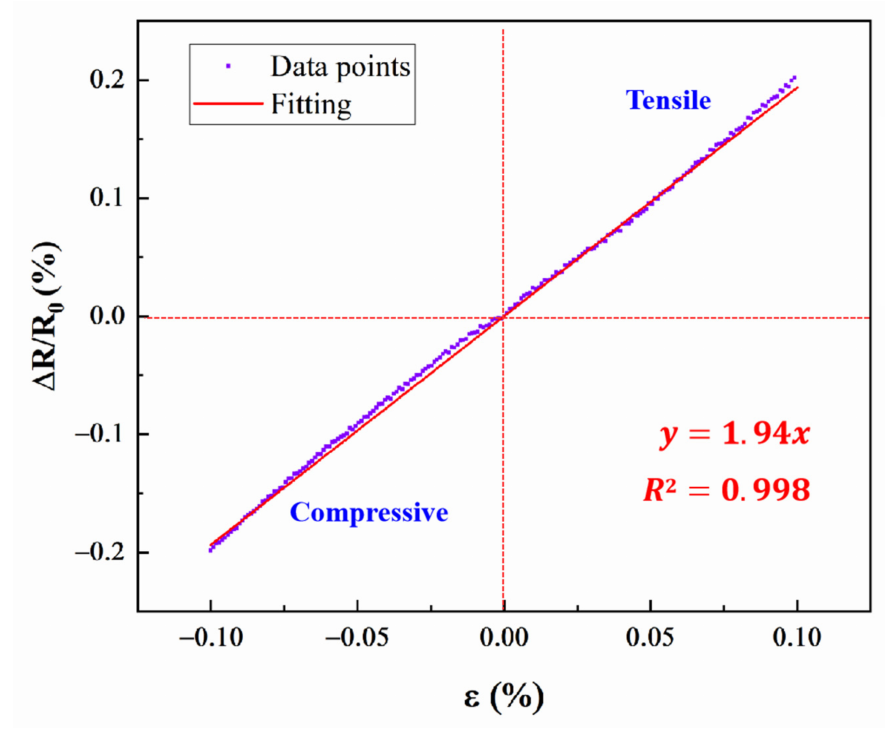
Figure 6. Linear fitting of tensile and compressive